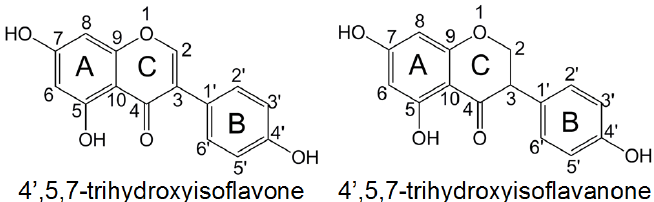
Figure 1. The chemical structures of 4 ′ ,5,7-trihydroxyisoflavone and 4 ′ ,5,7-trihydroxyisoflavanone.